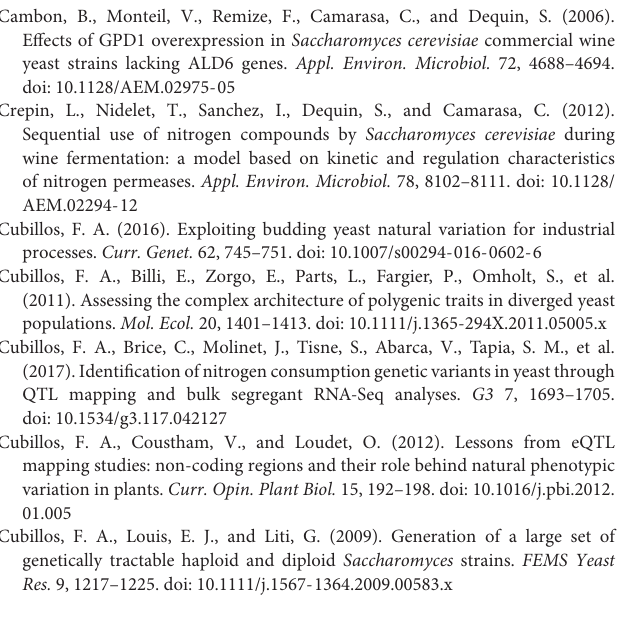
TABLE S1 | Primers used in this study. TABLE S2 | Physico-chemical characteristics of must after fermentations. TABLE S3 | Genes involved in ethanol and glycerol production in yeast and evaluated for ASE. TABLE S4 | Reciprocal hemizygotes’ physico-chemical characteristics of must after